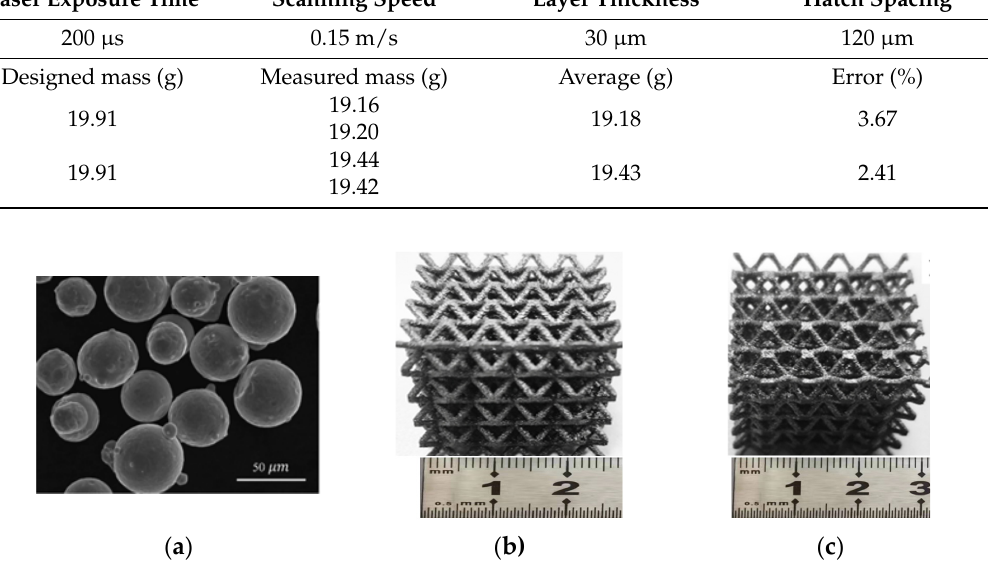
Figure 4. ( a ) 316L stainless steel powder, ( b ) O-la tt ice, and ( c ) Bambusa-la tt